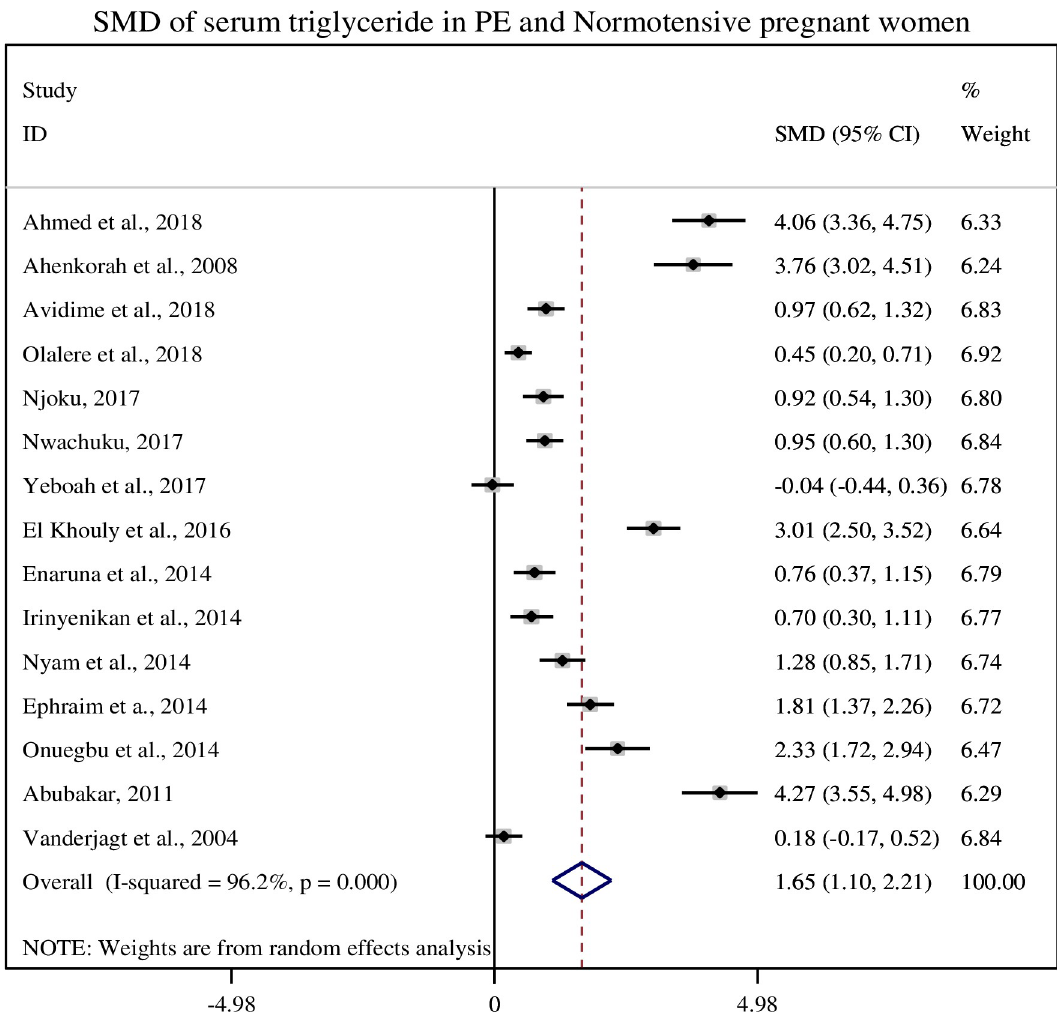
Fig 3. Forest plot of standardized mean difference of total triglycerides and